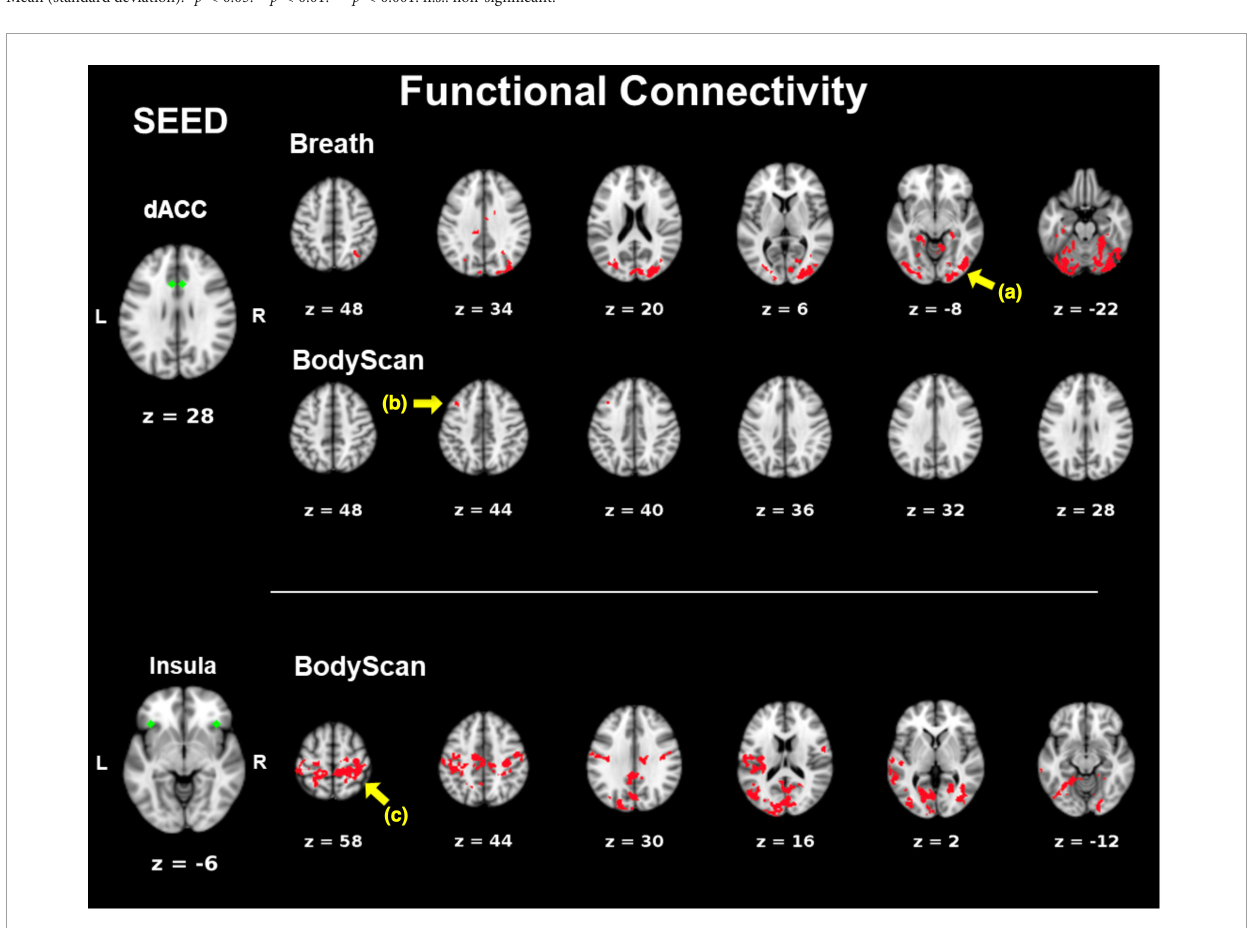
FIGURE1 POST–PRE comparison of FC in the MBSR group using TFCE. Seeds are marked in green. Areas of significant post-pre differences ( p < 0.05, FDR-corrected) in FC are marked in red. (a) The bilateral occipital lobe; (b) left middle frontal gyrus; (c) the precentral and post central gyri.